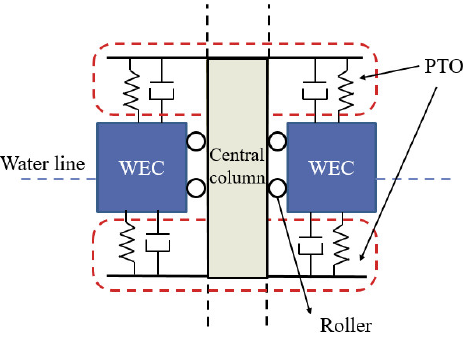
Figure 3. Simplified dynamic coupling model between the WEC and braceless.